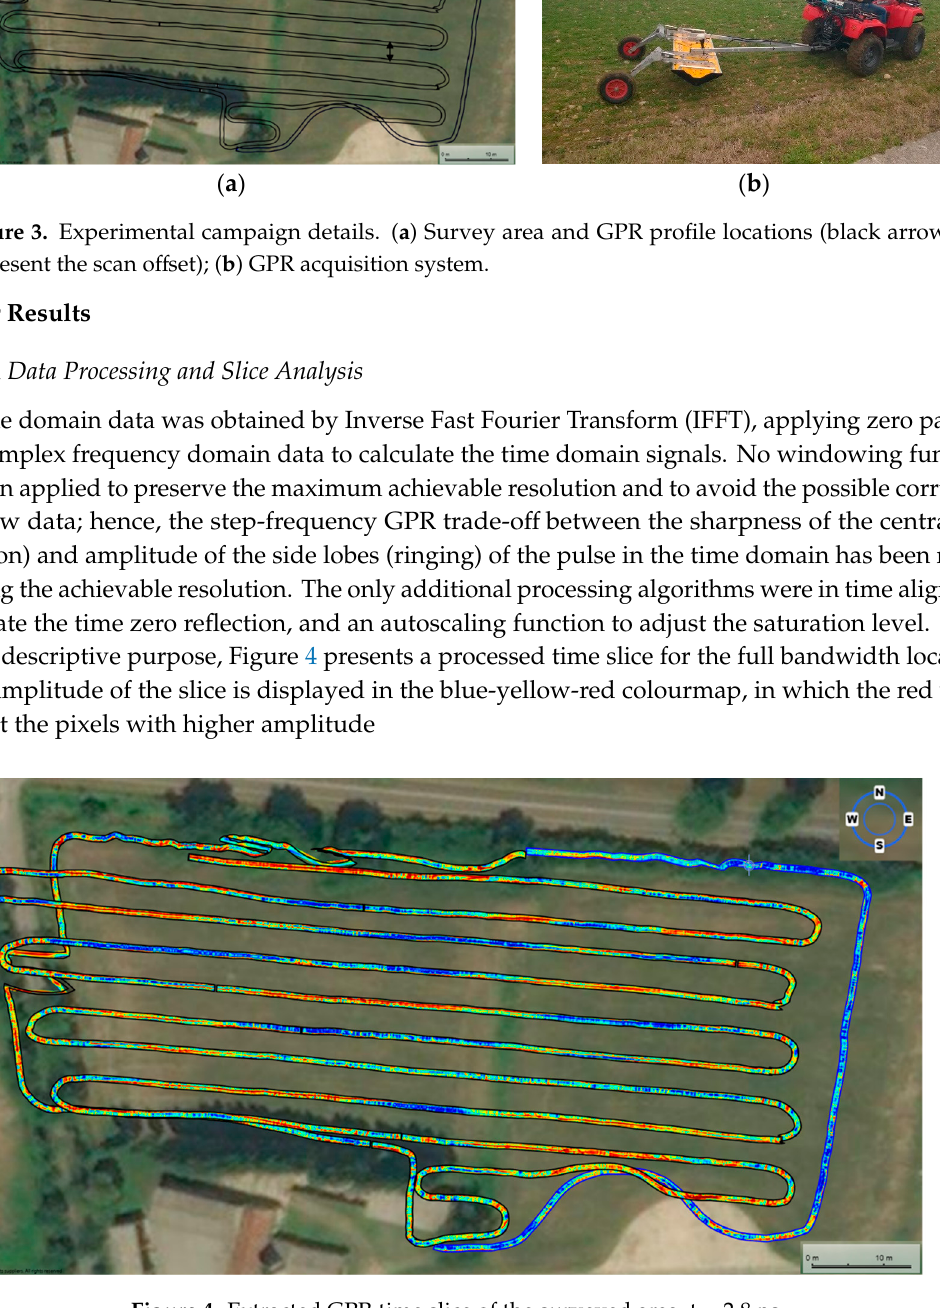
Figure 3. Experimental campaign details. ( a ) Survey area and GPR profile locations (black arrows